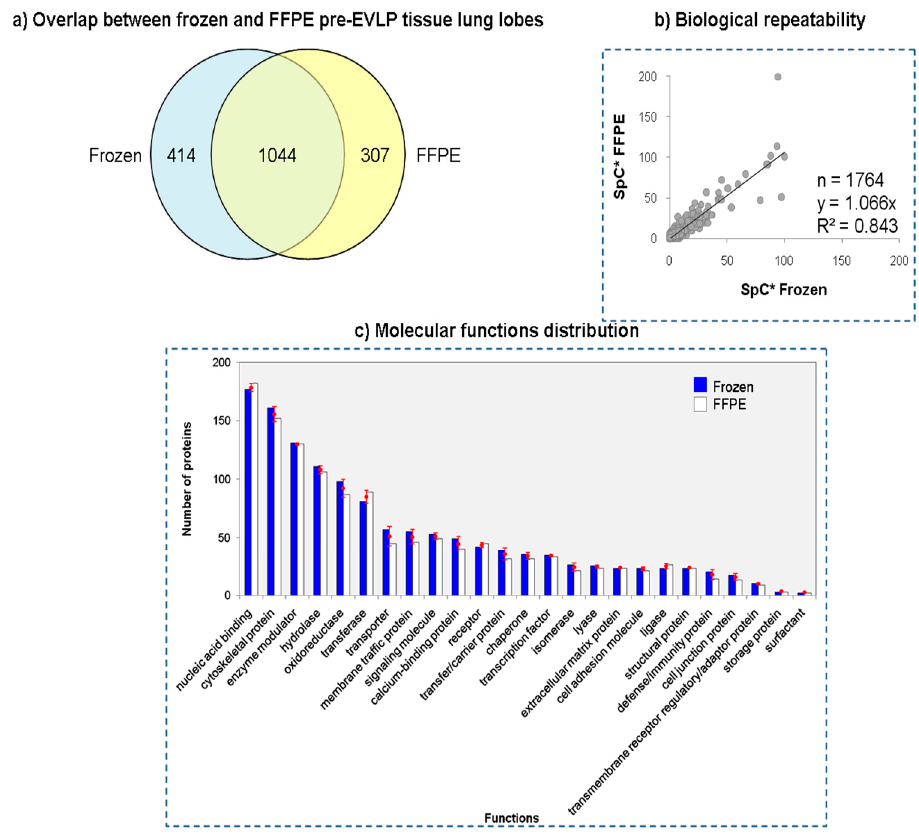
Figure 7. Comparison between frozen and FFPE pre-EVLP lung lobes. ( a ) Protein overlapping between frozen and FFPE in three pre-EVLP analyzed samples (IIL11, IIG13 and IIH15). ( b ) Plot of frozen vs. FFPE samples using normalized average spectral count (SpC*) values. ( c ) Distribution of proteins between the frozen and FFPE according to their molecular function using Protein ANalysis THrough Evolutionary Relationships (PANTHER) classification system. For each molecular function, reported as percentage of proteins for the two tissues (blue/solid colour for frozen and blank for FFPE datasets), the difference frozen vs FFPE was <0.9%.